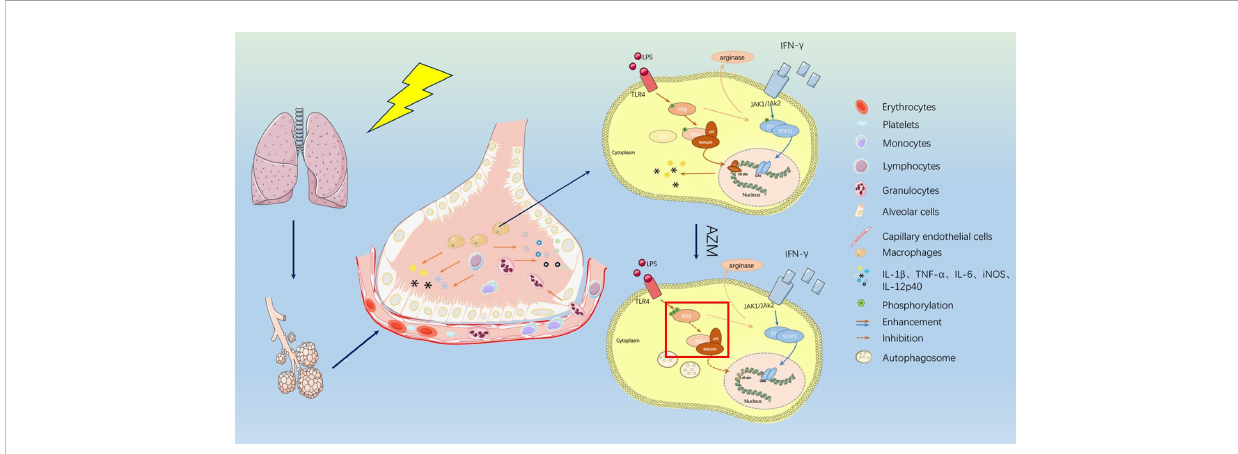
FIGURE 1 The mechanism of azithromycin in RILI patients. After ionizing radiation applied to lung tissue, alveolar barrier and vascular endothelial cells are damaged and vascular permeability is changed. Kinds of in fl ammatory cells like monocytes, lymphocytes, and macrophages are recruited here and released in fl ammatory cytokines such as IL-1beita, IL-6, iNOS, IL-12p40, TNF-a. Azithromycin can act on macrophages which made IKKb/NF-kB pathways suppressed. Azithromycin treatment increased the phosphorylation of IKKb resulting in inhibition of NF- kB translocation into the nucleus and resulting in inhibit signal transducer and activator of transcription-1(STAT-1) signaling. Both made in fl ammatory process affected and release of cytokines is